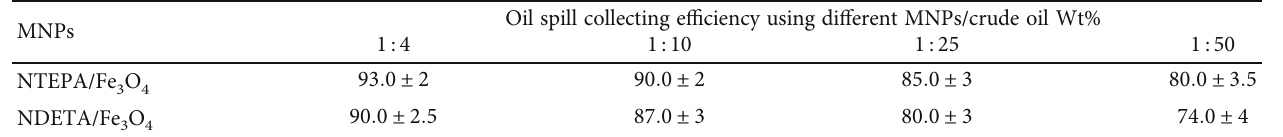
Table 1: Oil spill collecting e ffi ciencies (%) of MNPs at di ff erent MNPs/crude oil Wt%.